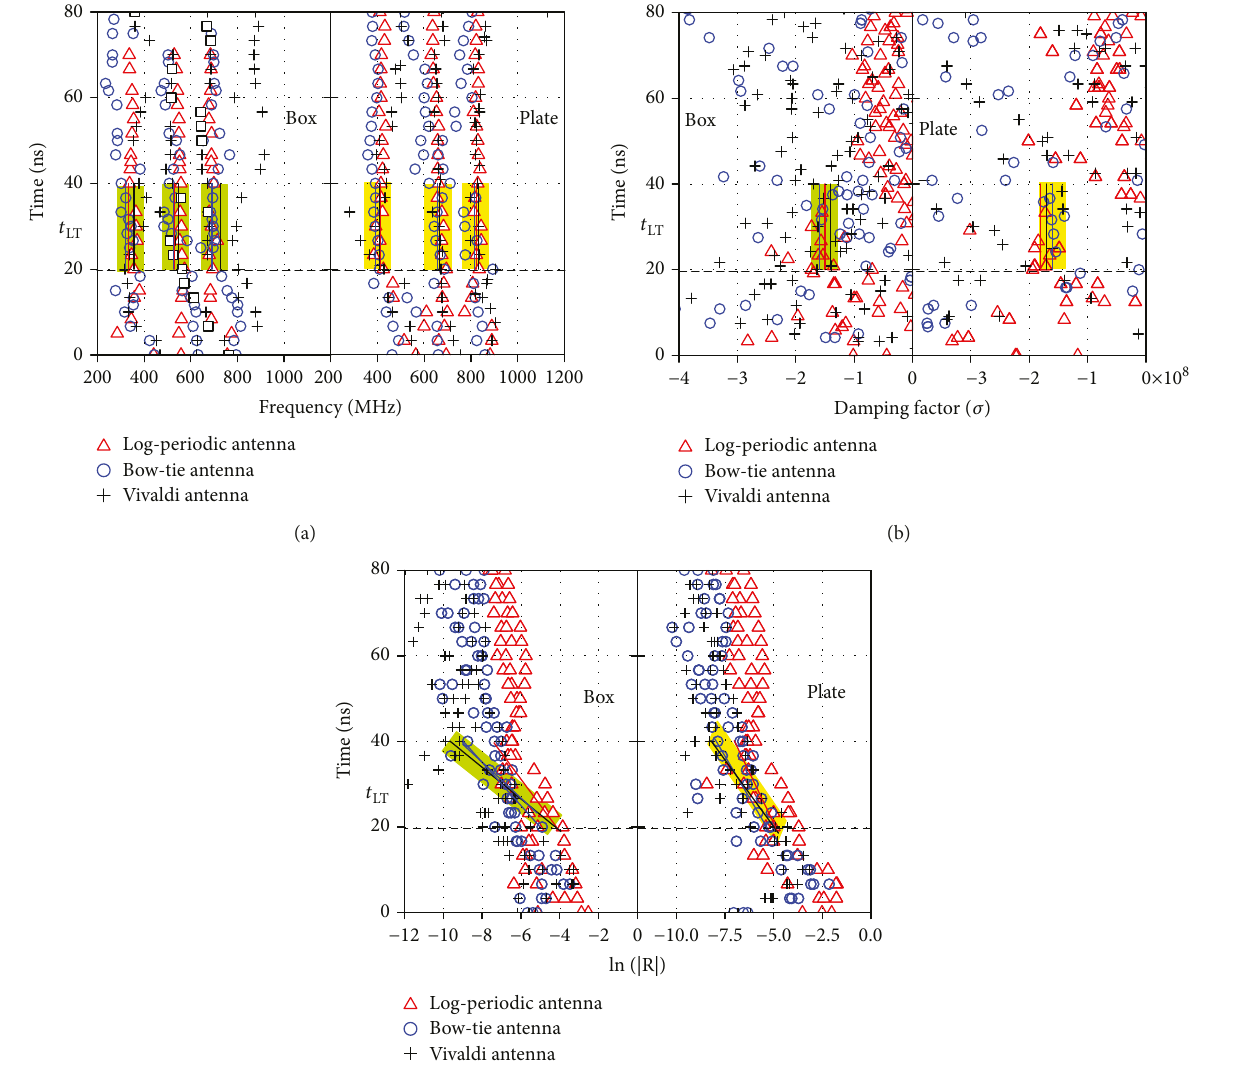
Figure 9: Extracted poles from experimentation with fi ltering the antenna e ff ects; (a) imaginary part (b) real part, and (c) magnitude of residues. Table 2: Summary of the extracted poles in the late time of experimental results. Averaged poles ( × 10 8 ) Pole extraction Object/antennas Box Plate Log-periodic N/A N/A Without the proposed method Bow-tie N/A N/A Vivaldi N/A N/A With the proposed method